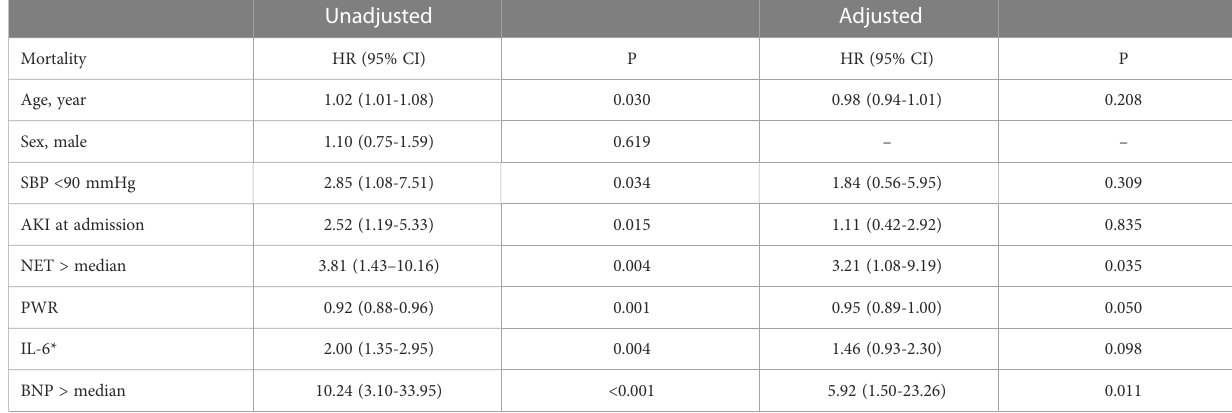
TABLE 3 Clinical Factors In fl uencing In-Hospital Mortality in COVID-19